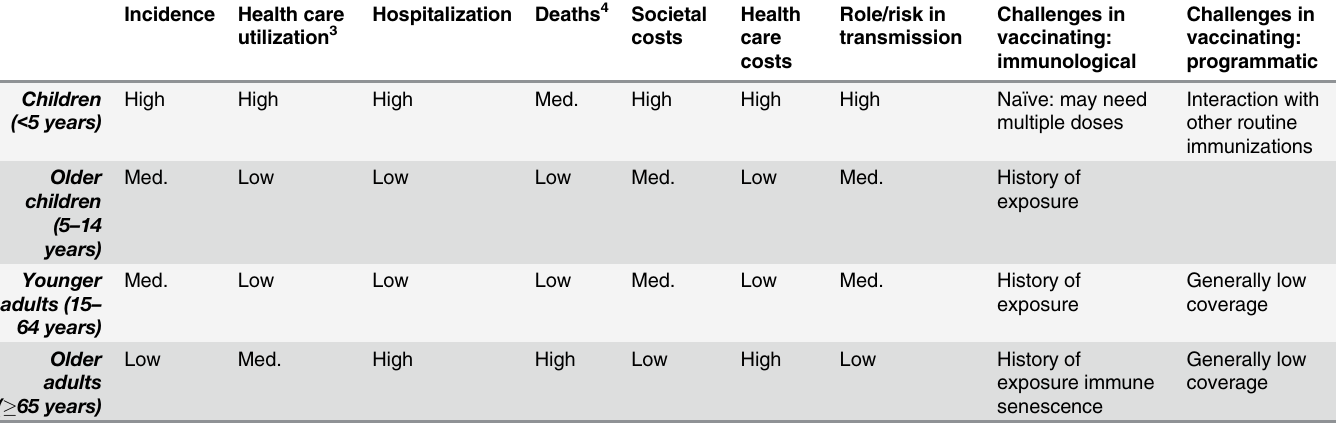
Table 1. Epidemiological and economics characteristics of various age groups for considering norovirus vaccines 1,2 .